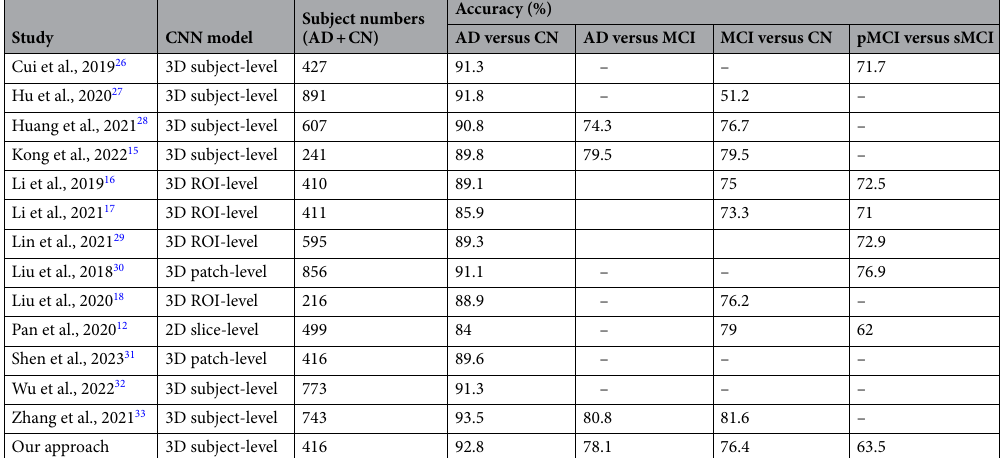
Table 8. Comparison of classification performance of state-of-art studies based on baseline sMRI data of ADNI. The subject number represents the total subject numbers used in training, validation and